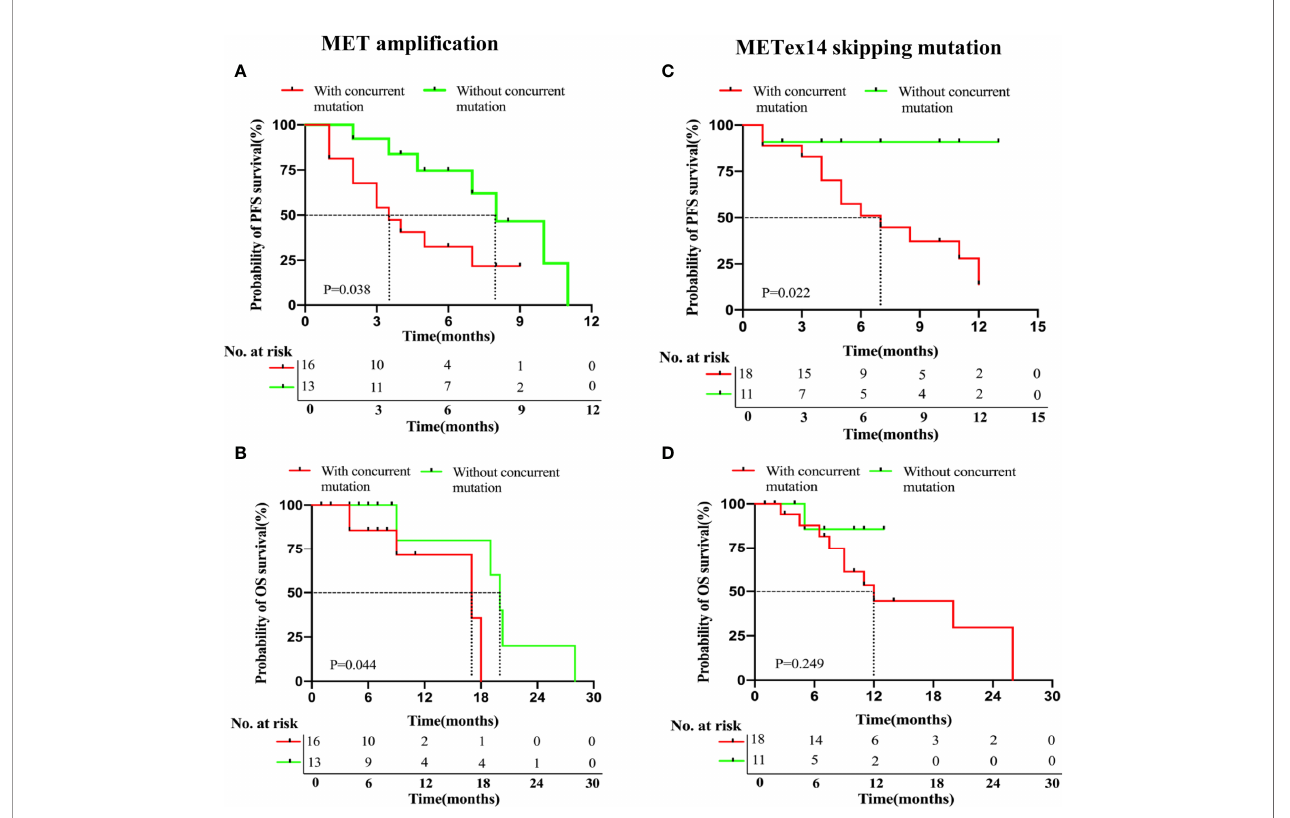
FIGURE 3 | NSCLC patients with MET ampli fi cation and METex14 skipping mutation harboring concurrent deleterious mutations have signi fi cantly shorter PFS with MET TKI therapy. Kaplan-Meier analyses for PFS (A, C) and OS (B, D) of patients based on the presence or absence of concurrent mutations in MET ampli fi cation and MET ex14 skipping mutation